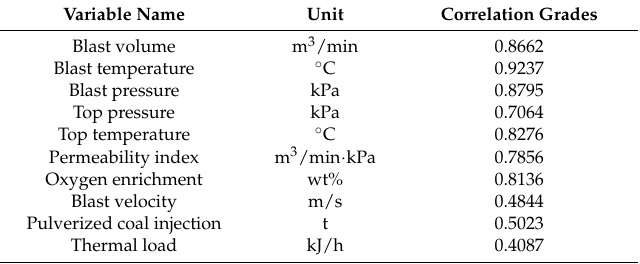
Table 1. Input variables description and correlation analysis results